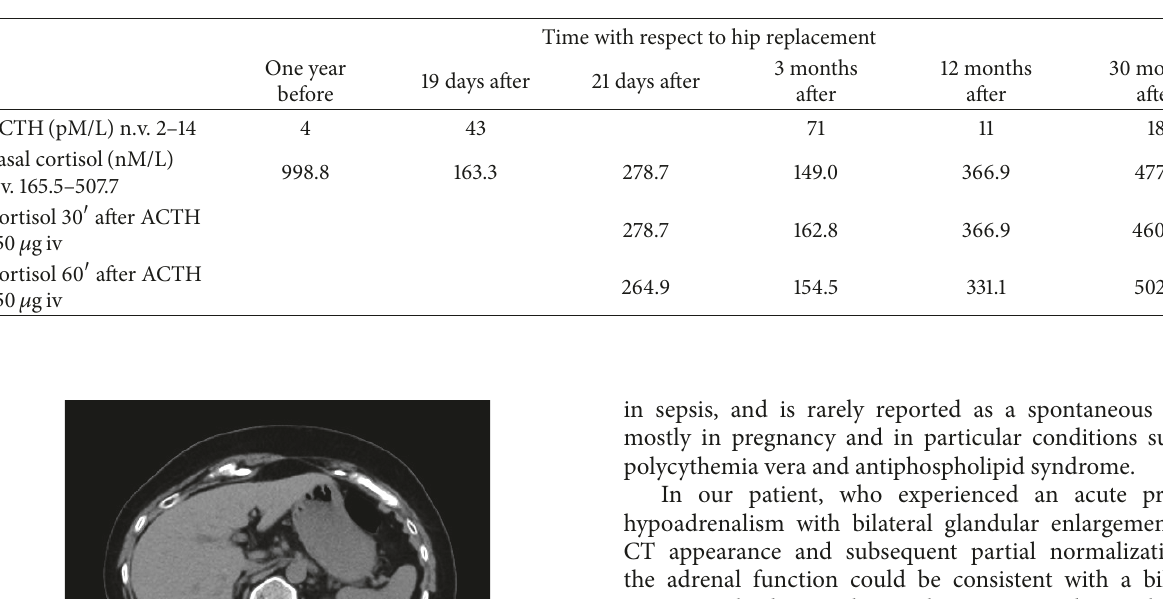
Table 2: Adrenal function before hip replacement and during follow-up.